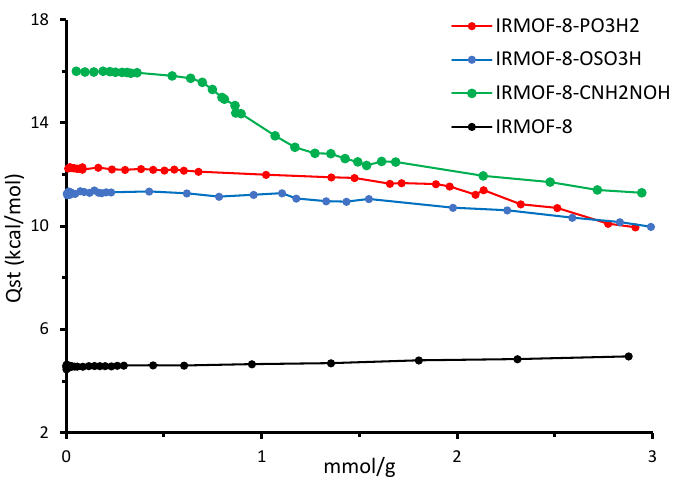
Figure 7. Isosteric heat of adsorption for the three modified IRMOF-8 materials and the parent one. Lines were added to guide the eye.